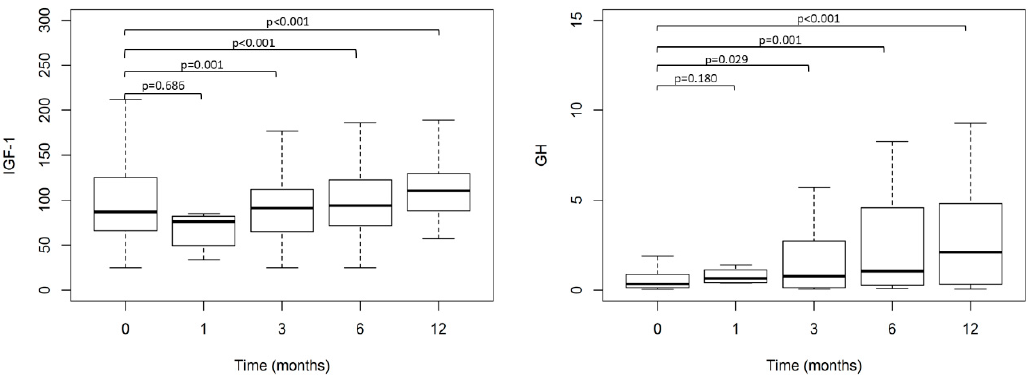
Figure 2. Evolution over time of IGF-1 and GH values (Median (IR)) before and after surgery ( zero, one, three, six and twelve months ).